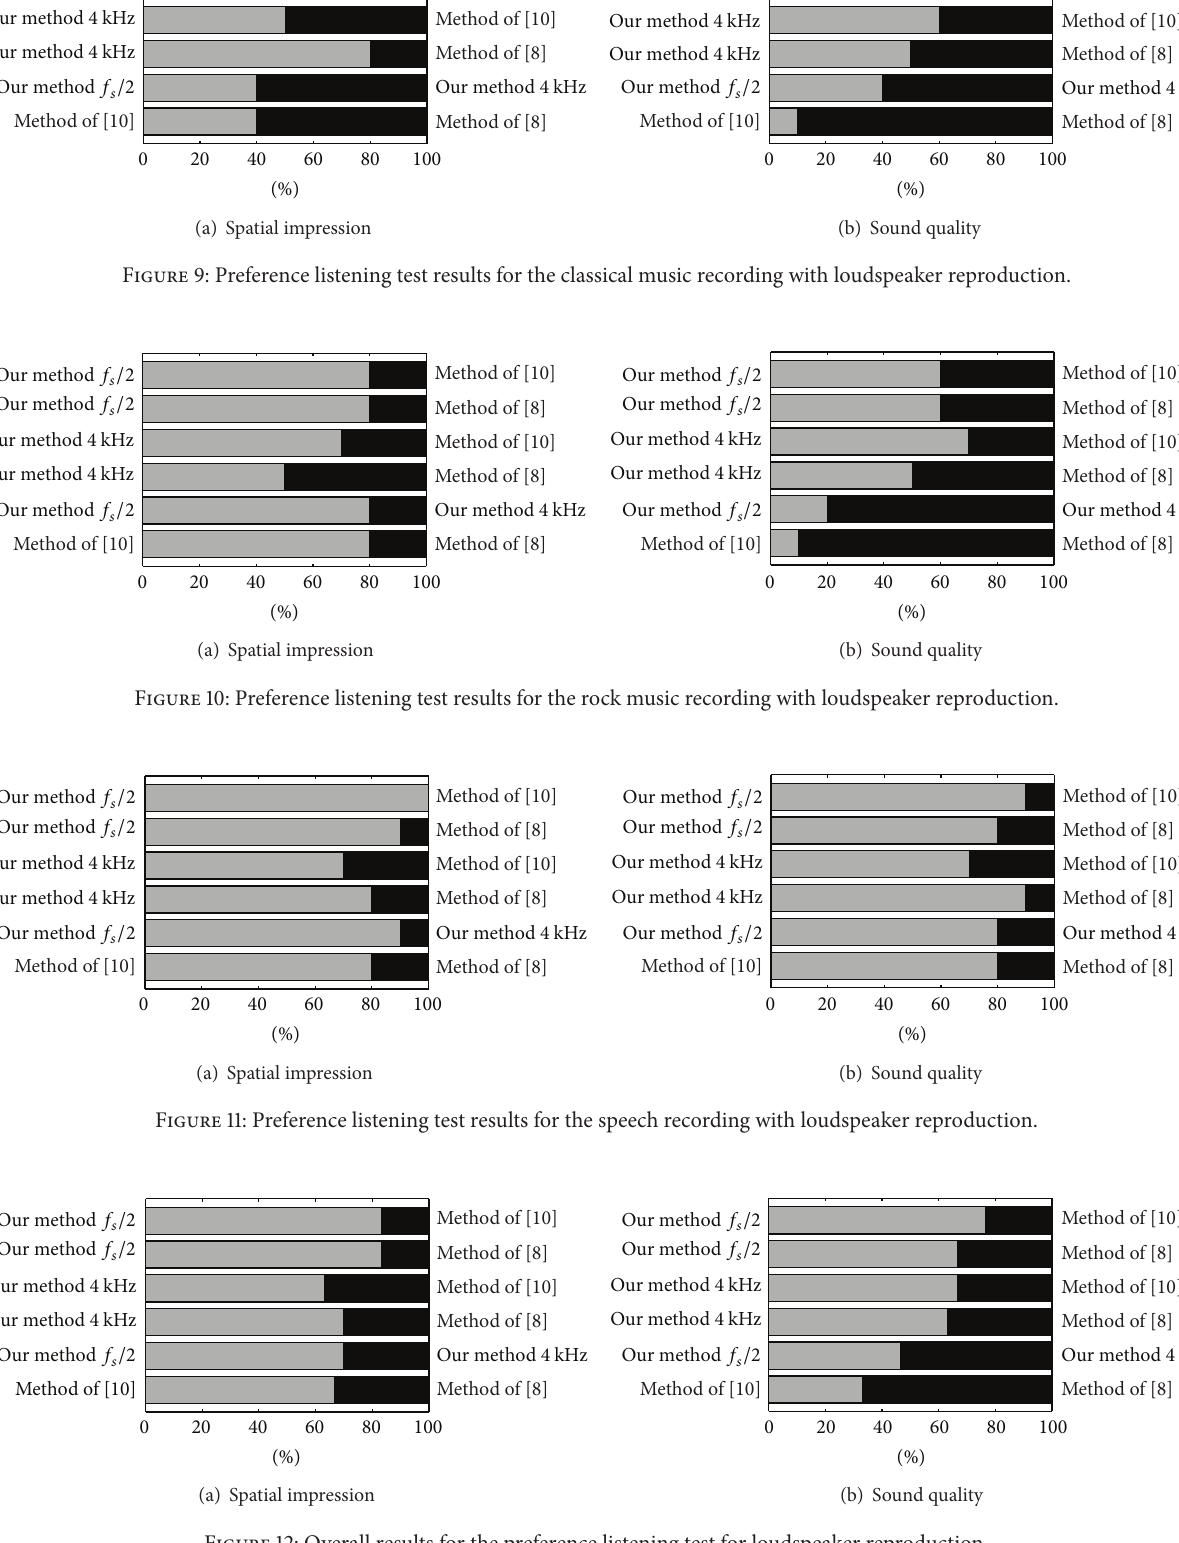
Figure 12: Overall results for the preference listening test for loudspeaker